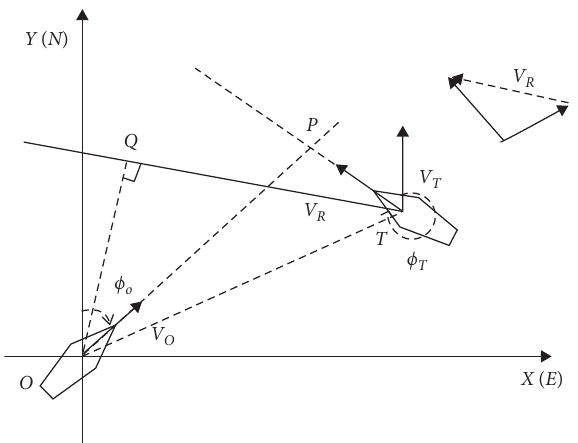
Figure 3: Rectangular coordinate system of own ship and target